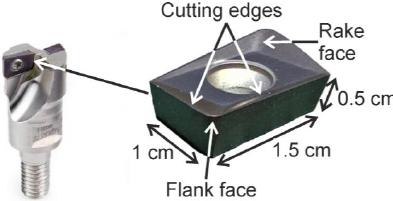
Figure 1. Widia ® mill insert dimensions and its position in the milling holder [24].